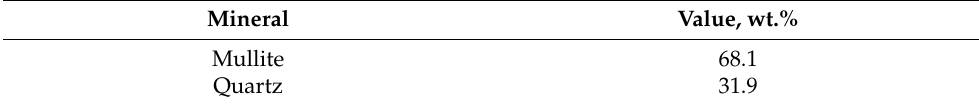
Table 1. Mineralogical composition of crushed ceramic